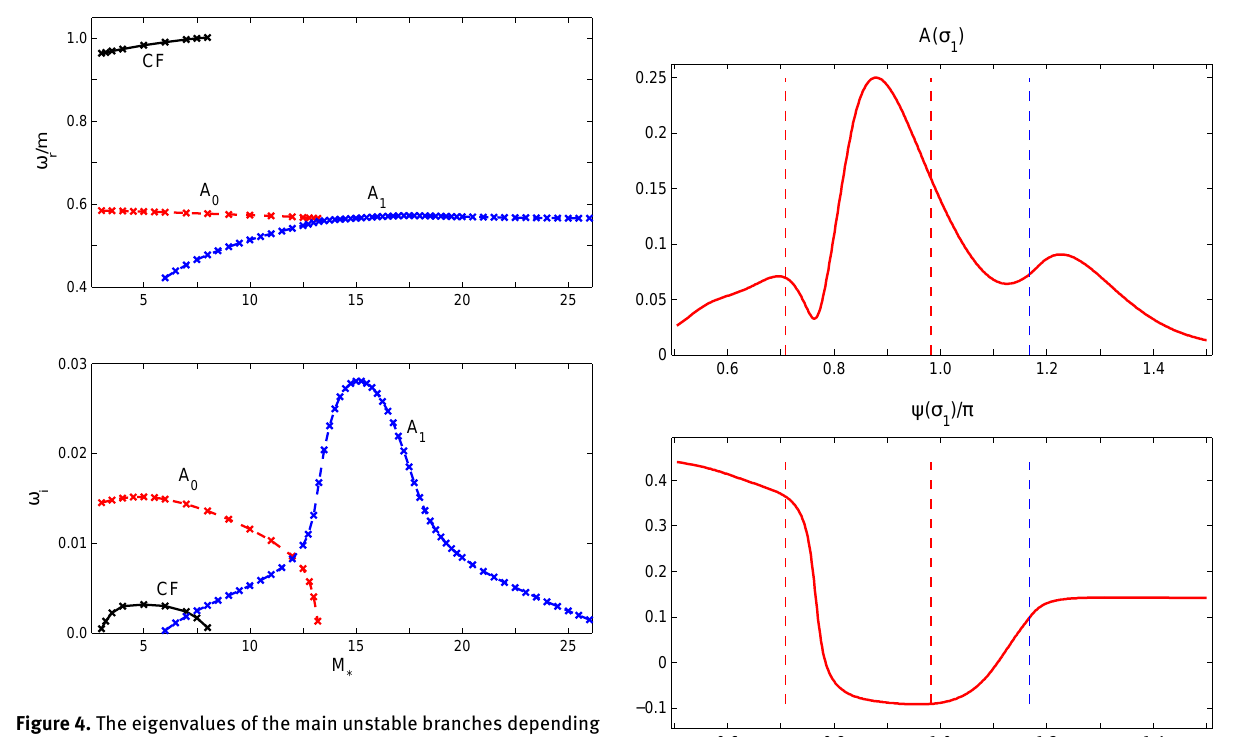
Figure 4. The eigenvalues of the main unstable branches depending on the parameter M * , in the model gas disk as in Figure (3), but with more realistic velocity profile, having the steepness velocity jump parameter α = −1.85. Ω min Figure 5. Amplitude (top) and phase (bottom) of the perturbed sur- face density σ 1 ( r , φ ) for eigenfunction, corresponds to the eigen- value ω of unstable branch A 1 , azimuthal harmonic m = 2, see Fig- ure 4, with fixed value of parameter M * = 15.0. The model disk has uniform unperturbed surface density, and rotation profile (7), (8), with parameters (10). Here the annular radial interval encompassing the region of the velocity jump is represented. Vertical dashed lines show the radii of resonances: blue - corotation, red - Lindblad’s. In the shown here annular region, there are two internal Lindblad resonances, the outer one is somewhat further along the